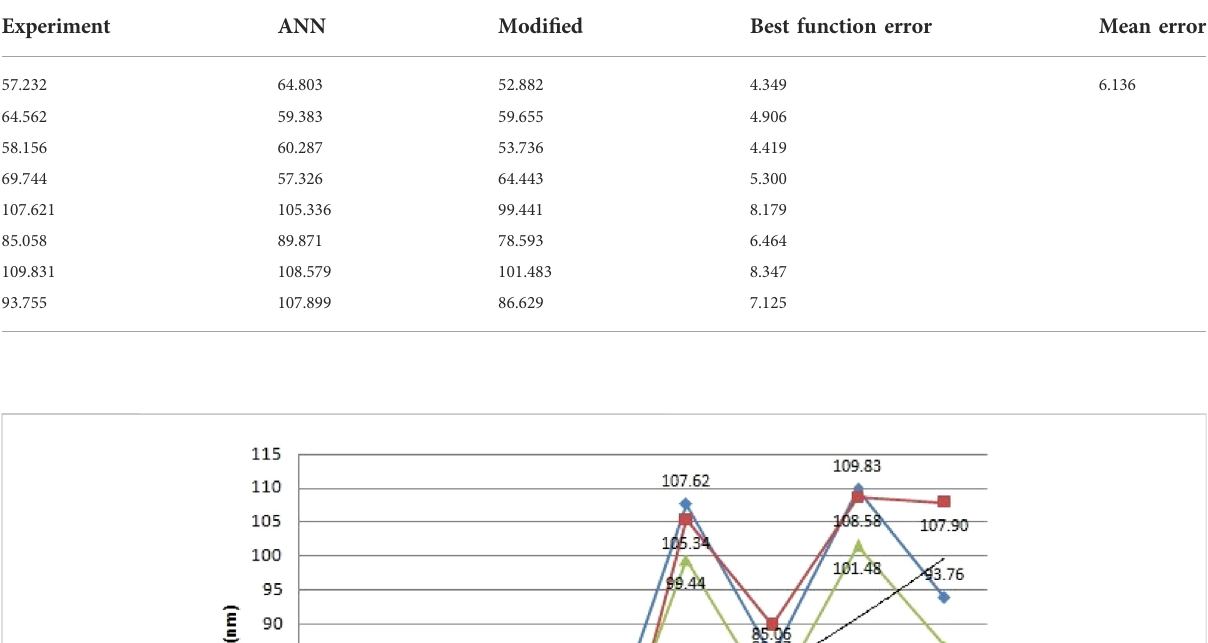
TABLE 3 Experimental, ANN, and modi fi ed R with mean error.